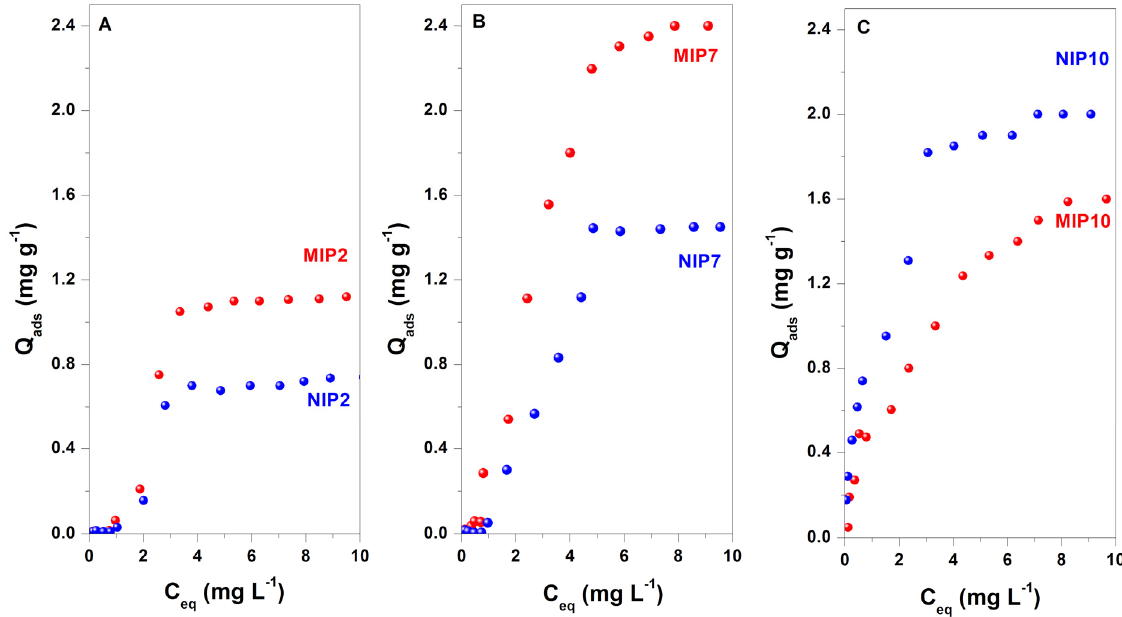
Figure 5. Adsorption isotherms of MIP2 ( A ), MIP7 ( B ), MIP10 ( C ), and their corresponding non-imprinted polymers.